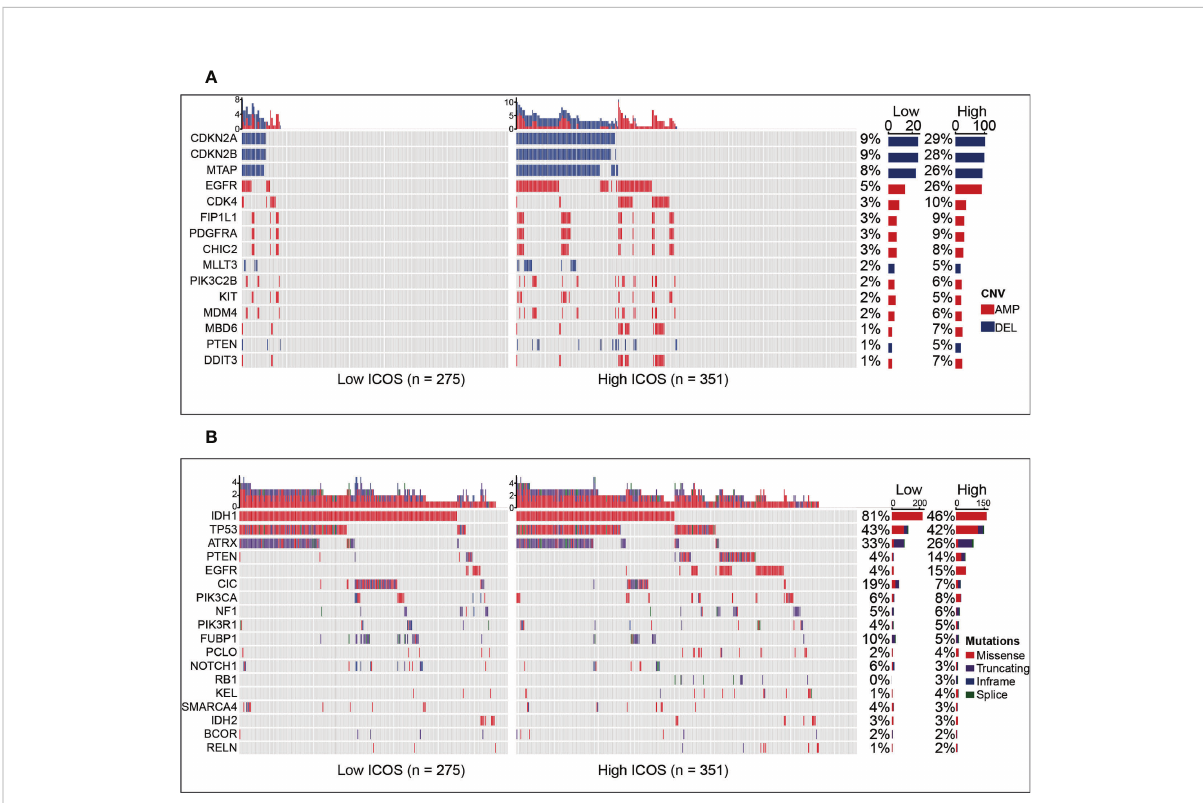
FIGURE 2 Comparison of genomic alterations between the high- and low-ICOS groups in the TCGA dataset. (A) Differential copy number variations (CNVs) between the high- and low-ICOS groups. (B) Differential somatic mutations between the high- and low-ICOS groups. AMP, ampli fi cation; DEL,